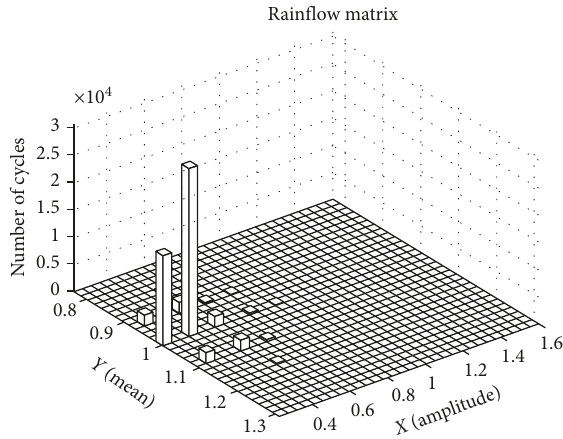
Figure 8: Diagram of statistical results for the rainflow-counting